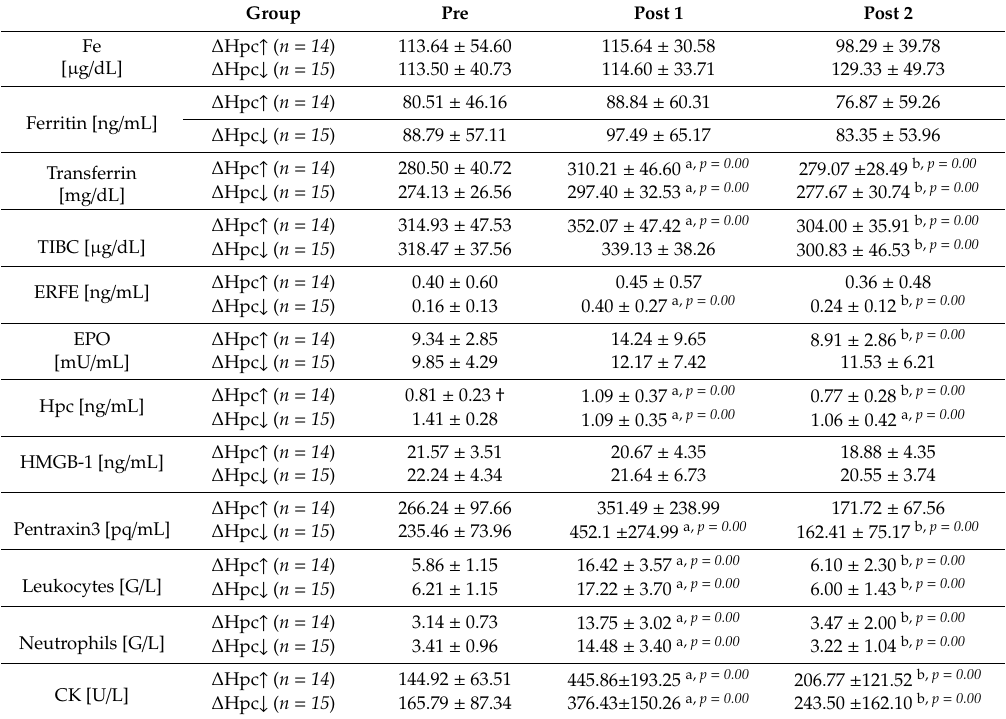
Table 3. Marathon run-induced changes in serum hepcidin (Hpc) levels are related to the increase in serum ERFE levels.